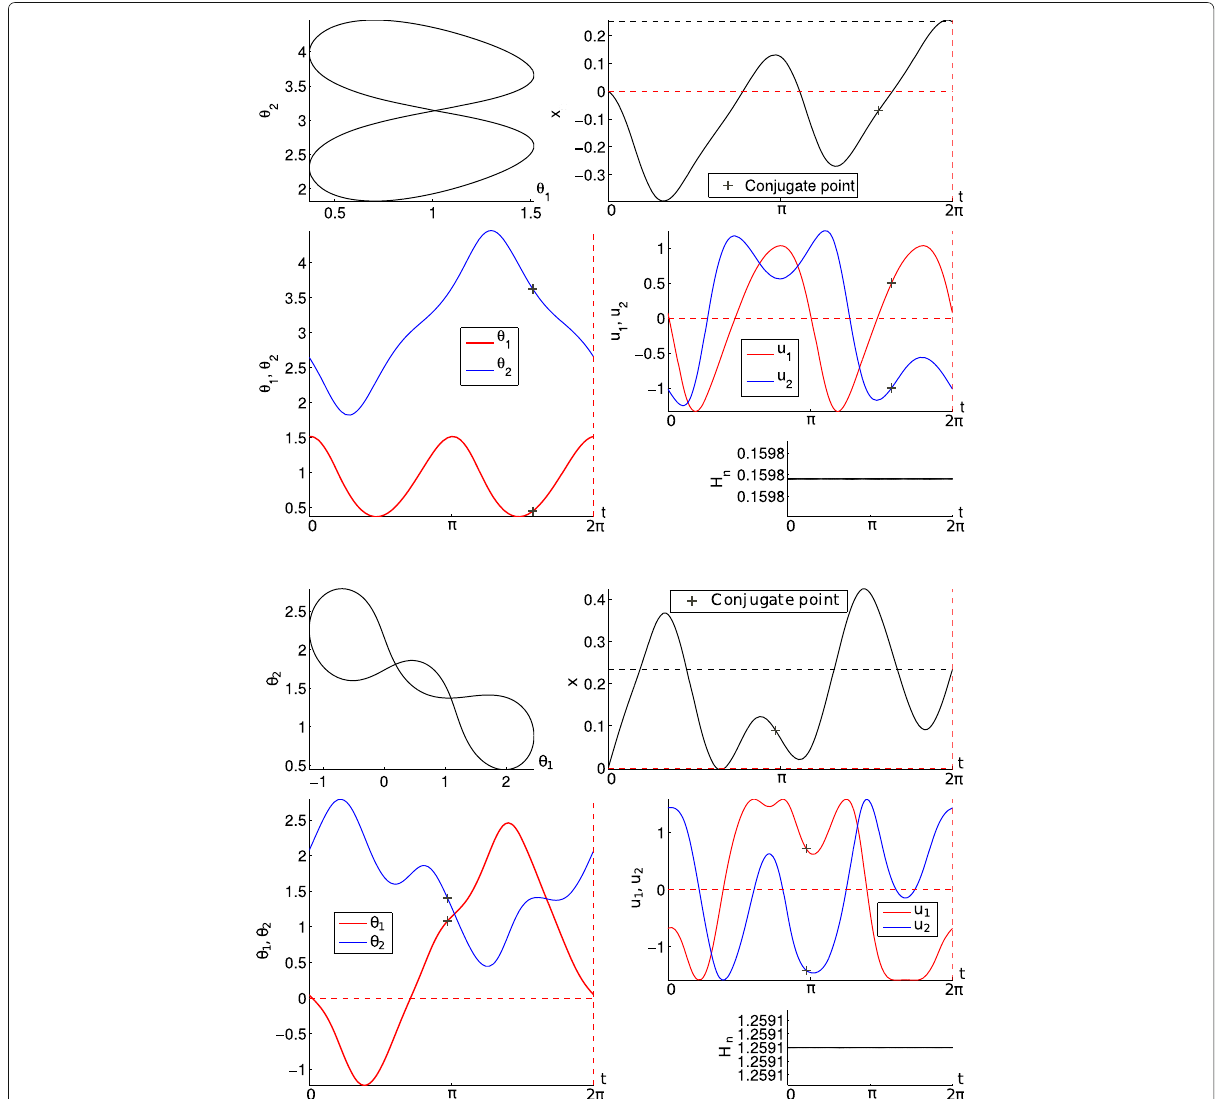
Fig. 8 Normal strokes: two self-intersecting case. First conjugate points on [0,2 π ] are computed with a svd test and they appear with a cross